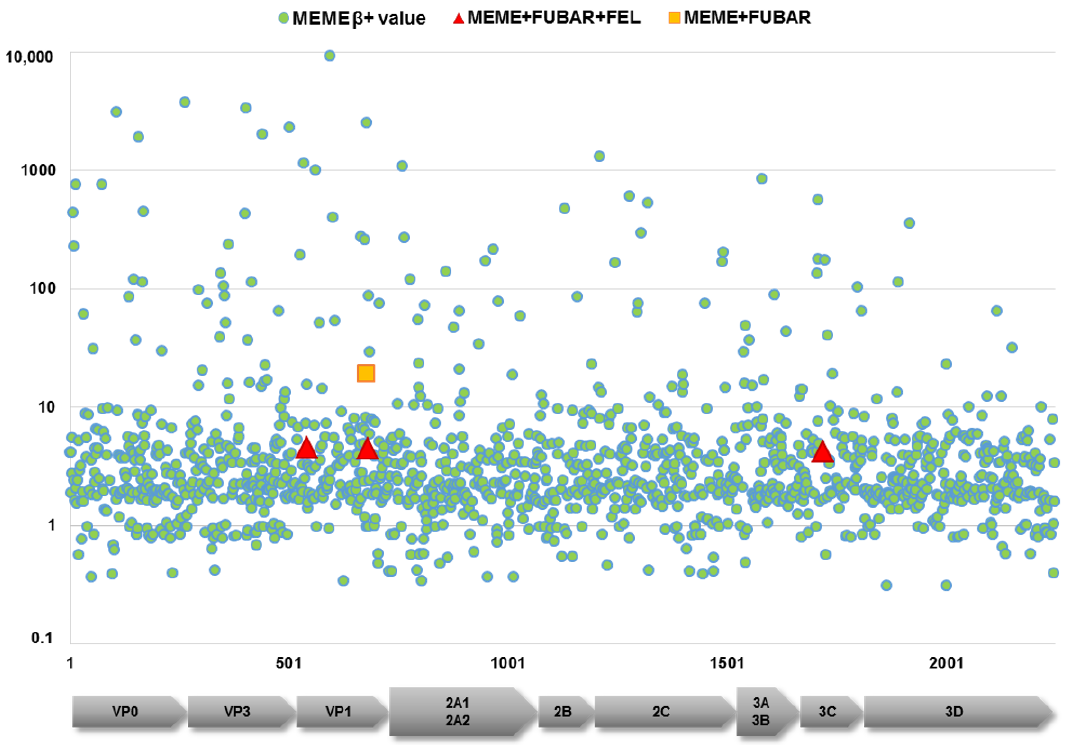
Figure 3. Results of the selection constraint analysis. β + values ( y -axis) at individual sites ( x -axis) were extracted and plotted from results of the MEME analysis (green circles). Sites under positive selection predicted with high significance values are labeled with red triangles and the yellow